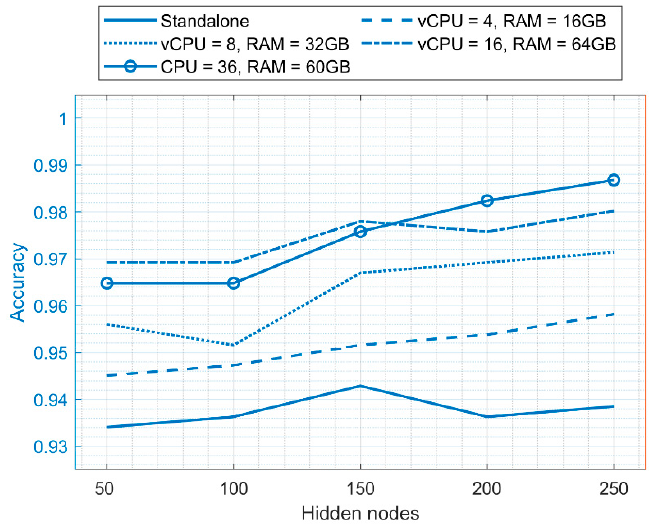
Figure 7. Comparison of the accuracy achieved when using standalone and cloud computing environments.